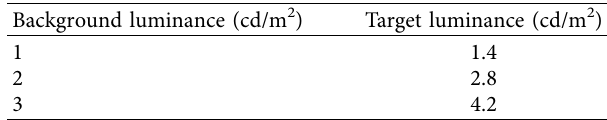
Table 1: The corresponding target luminance to different back- ground